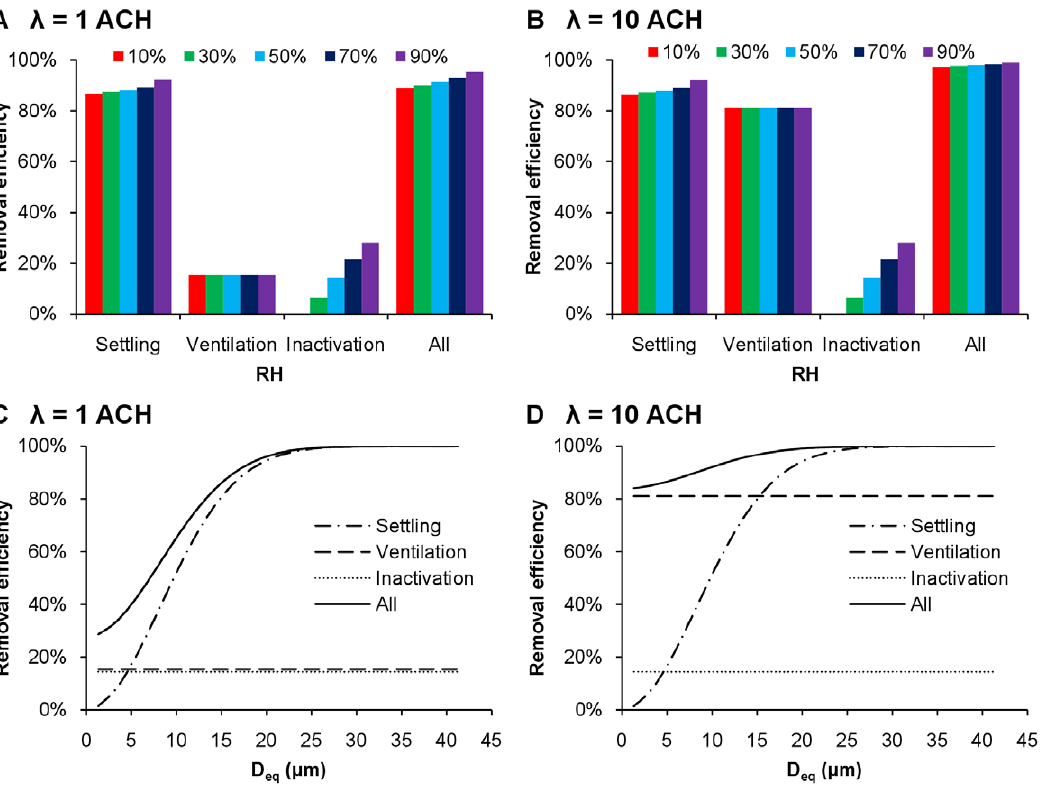
Figure 5. IAV removal mechanisms. Infectious IAV removal efficiencies due to settling, ventilation, and inactivation in residential (A) and public (B) settings at different RHs. Removal efficiency of settling, ventilation, and inactivation as a function of droplet size in residential (C) and public (D) settings at 50% RH. Removal efficiencies are shown for each mechanism independently and do not sum to 100% because in actuality, more than one mechanism may act on the same